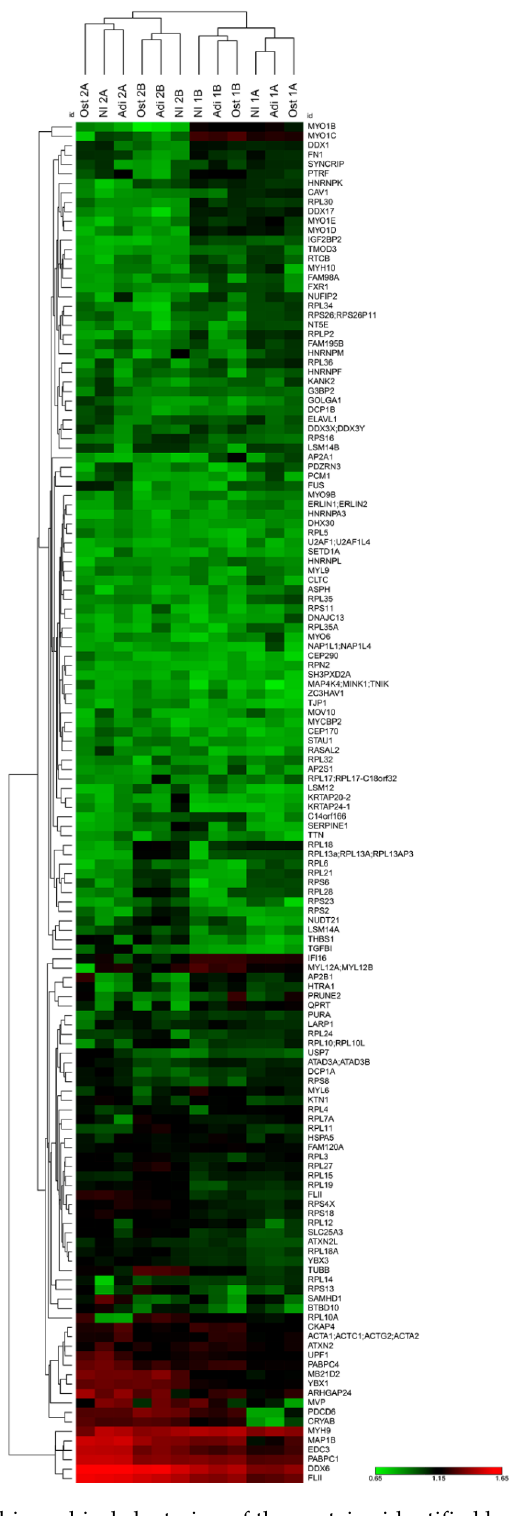
Figure 5. Heatmap and hierarchical clustering of the proteins identified by coimmunoprecipitation with DDX6 in the hASCs not induced or induced to adipogenesis or osteogenesis for 24 h. Samples were clustered first by technical (A and B) and then by biological (donors 1 and 2) replicates, not by condition (NI, Adi and Ost). The heatmap shows that the general composition of DDX6-associated complexes is similar during the first 24 h of adipogenic or osteogenic induction.